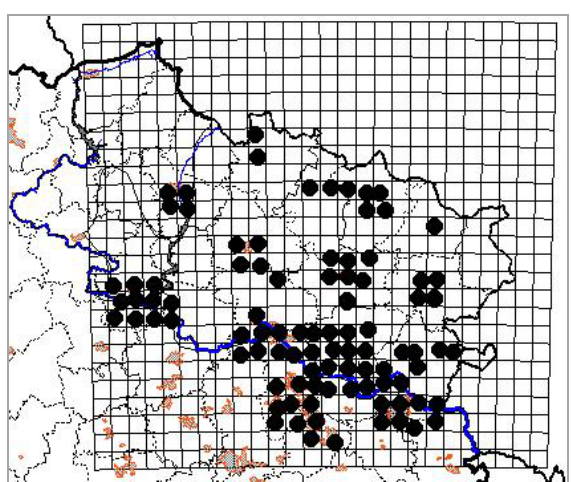
Fig. 11. The map of the distribution of Cardaria draba (L.) Desv. in the Starobilsk grass-meadow steppe